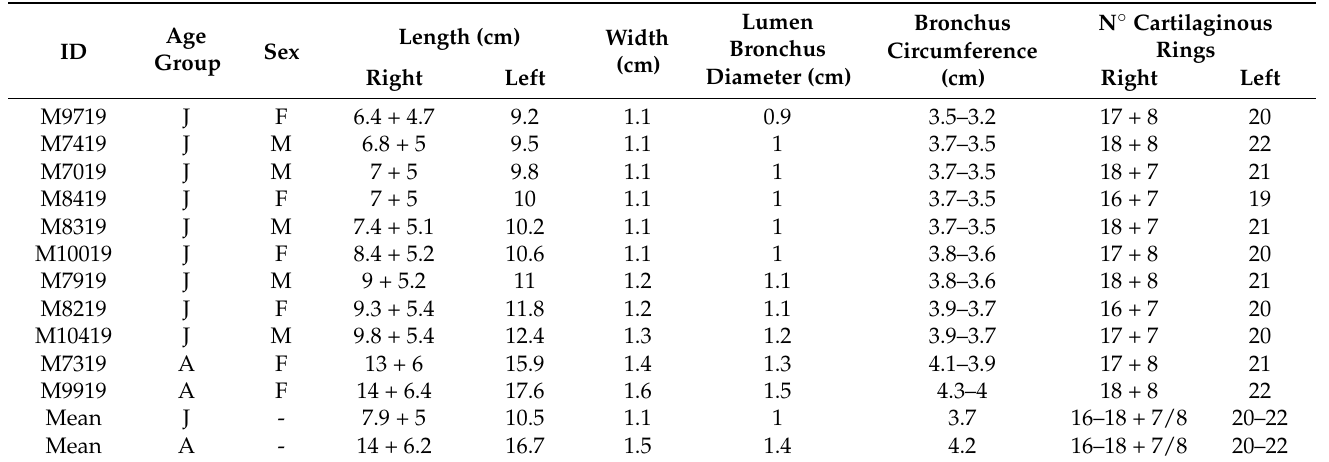
Table 2. The morphometric data of the bronchi from the 11 individuals of Arctocephalus australis investigated in the present study. A: adult; J: juvenile.